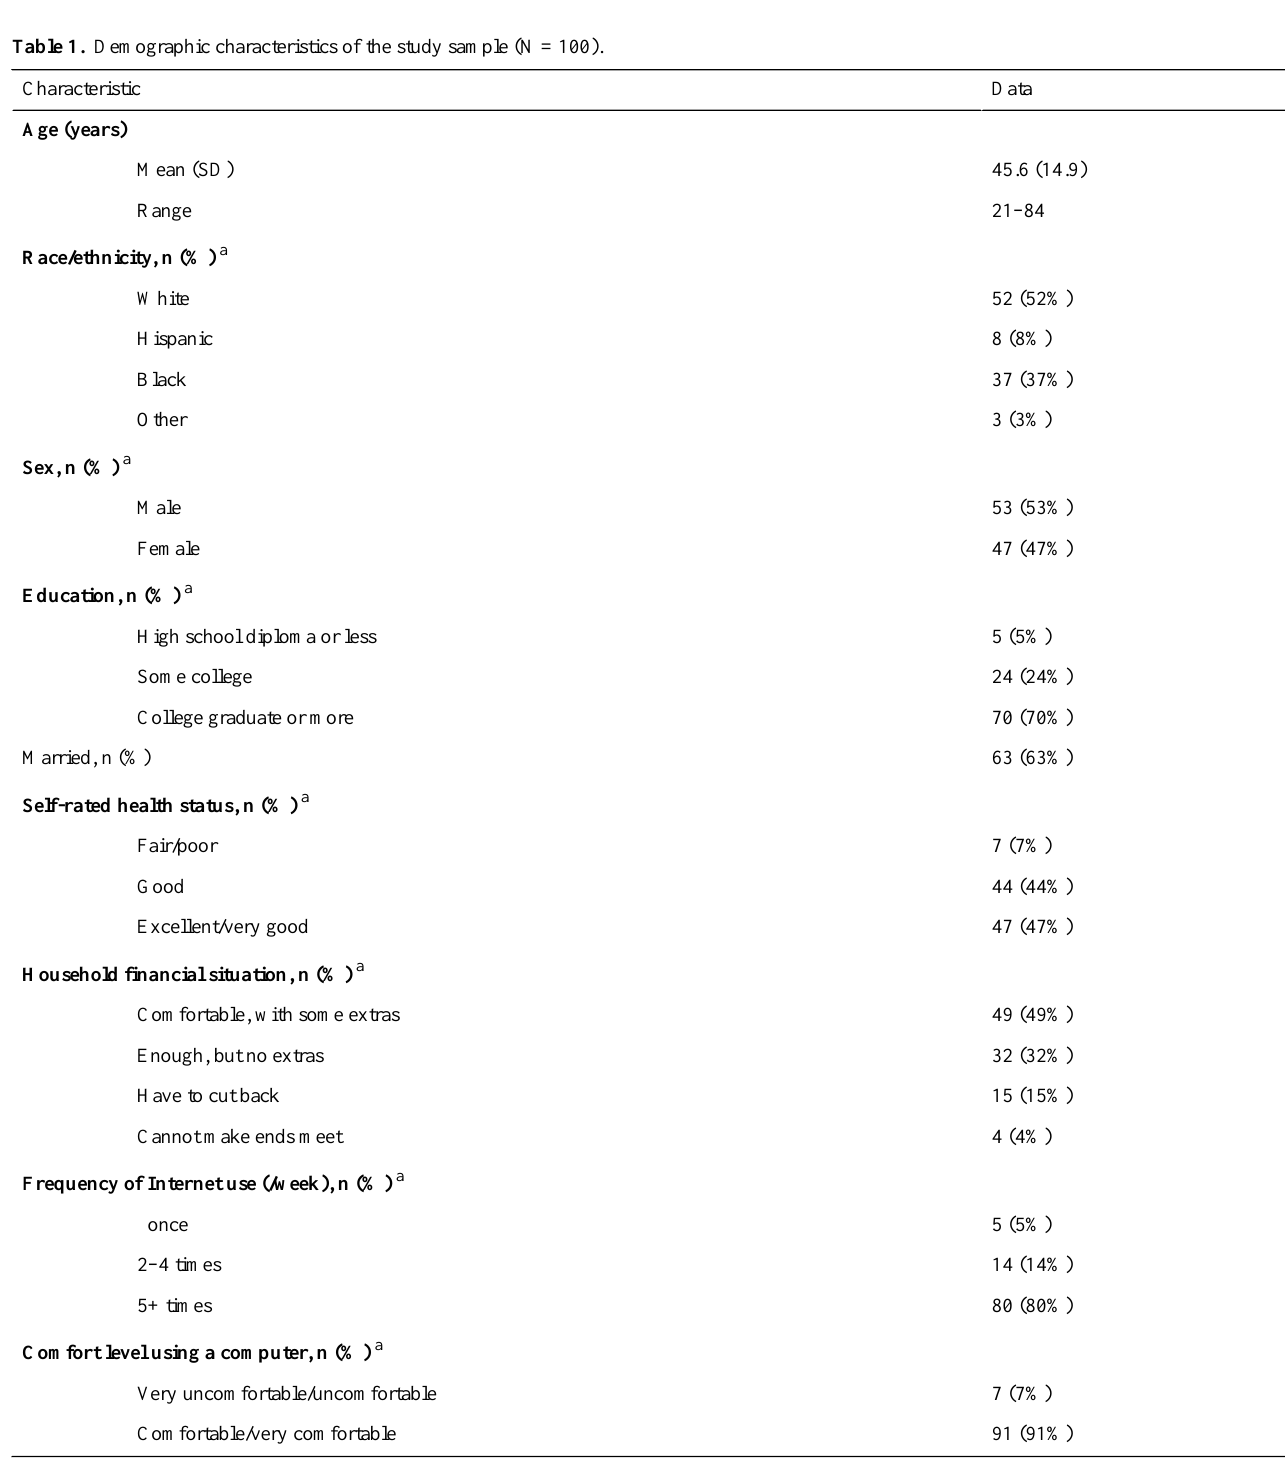
Table 1. Demographic characteristics of the study sample (N =